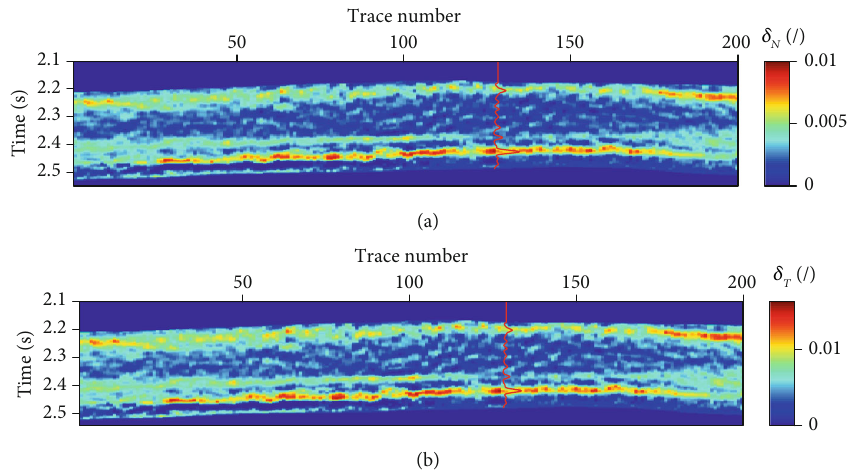
Figure 13: Inverted fracture weaknesses of a TTI medium, where (a) shows the normal fracture weakness and (b) shows the tangential fracture